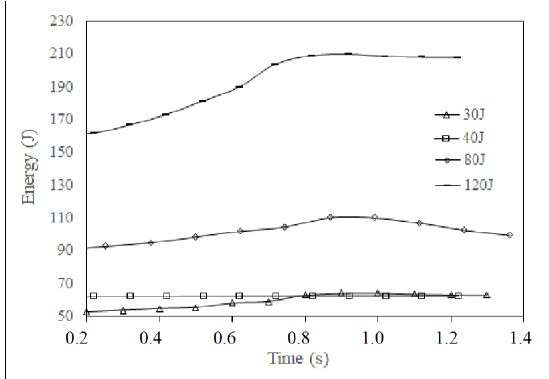
Figure 23. Energy absorbed by impact of weight drop tests on modified panels.